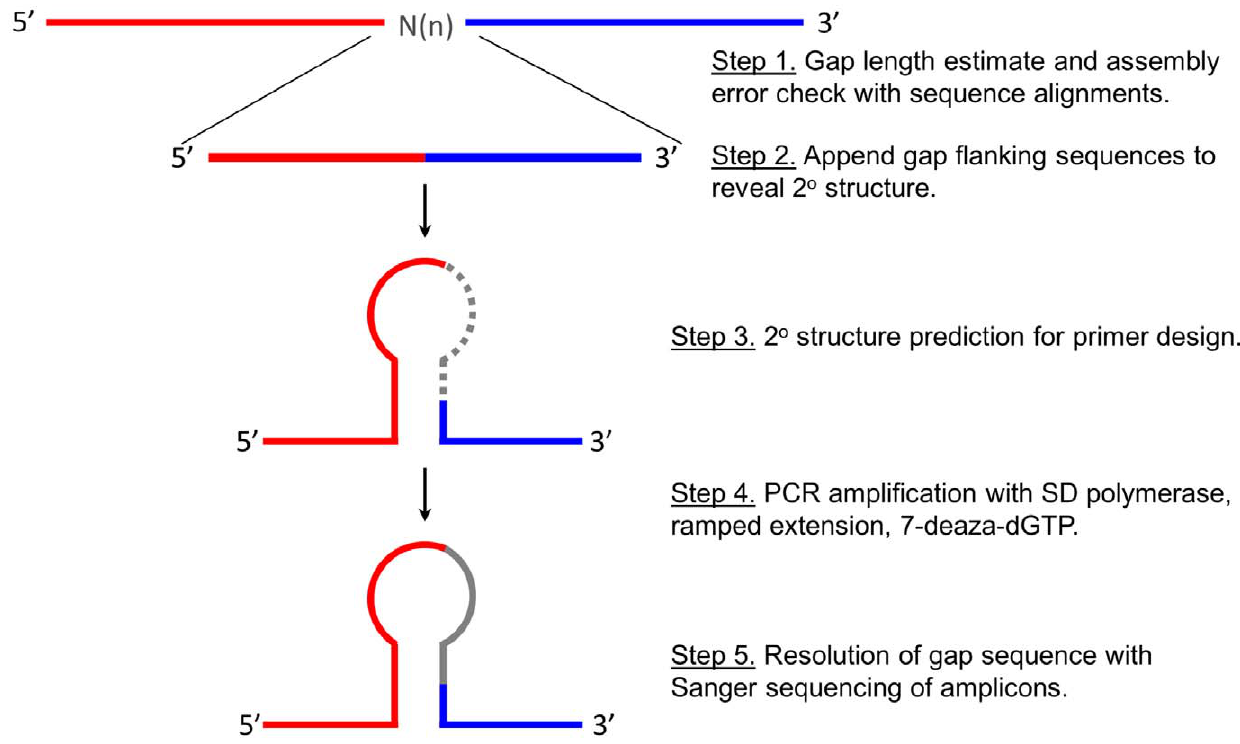
Figure 2. Work Flow Diagram. Top- 100 nt from either side of the gap are appended and used for alignment search to identify and potential problems with assembly causing the gap. N (n) denotes unknown nucleotides (50 or 100 by convention) inserted into the gaps in deposited sequence data The resulting 200 nt artificial contig is subjected to 2 u structure analysis. The folding analysis reveals additional 2 u structures in the vicinity of the gap that may present added difficulty with amplification and sequencing. Primers are targeted to positions proximal to the gap relative to any additional problems identified in the folding evaluation. Where the gap position is involved with secondary structure, amplification with an SD polymerase and use of a two-step extension cycle (1 min at 72 u C followed by 1 min at 75 u C) supports amplification. The second segment of the extension cycle can be modified based on the thermal stability identified in the initial folding analysis.